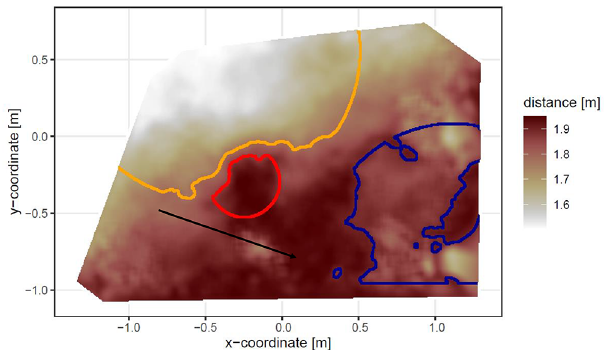
Figure 4. Corrected digital surface model of the camera on the north-facing upper hillslope at La Campana with delineated areas. The point of origin of the coordinate system is at the camera nadir. Distance refers to the distance between surface and camera. The red line delineates the burrow entrance, the blue line delineates the mound, and the orange line delineates the burrow roof. The area that was outside of any delineated area was classified as burrow- embedded area. The arrow indicates a downhill direction of the hill-